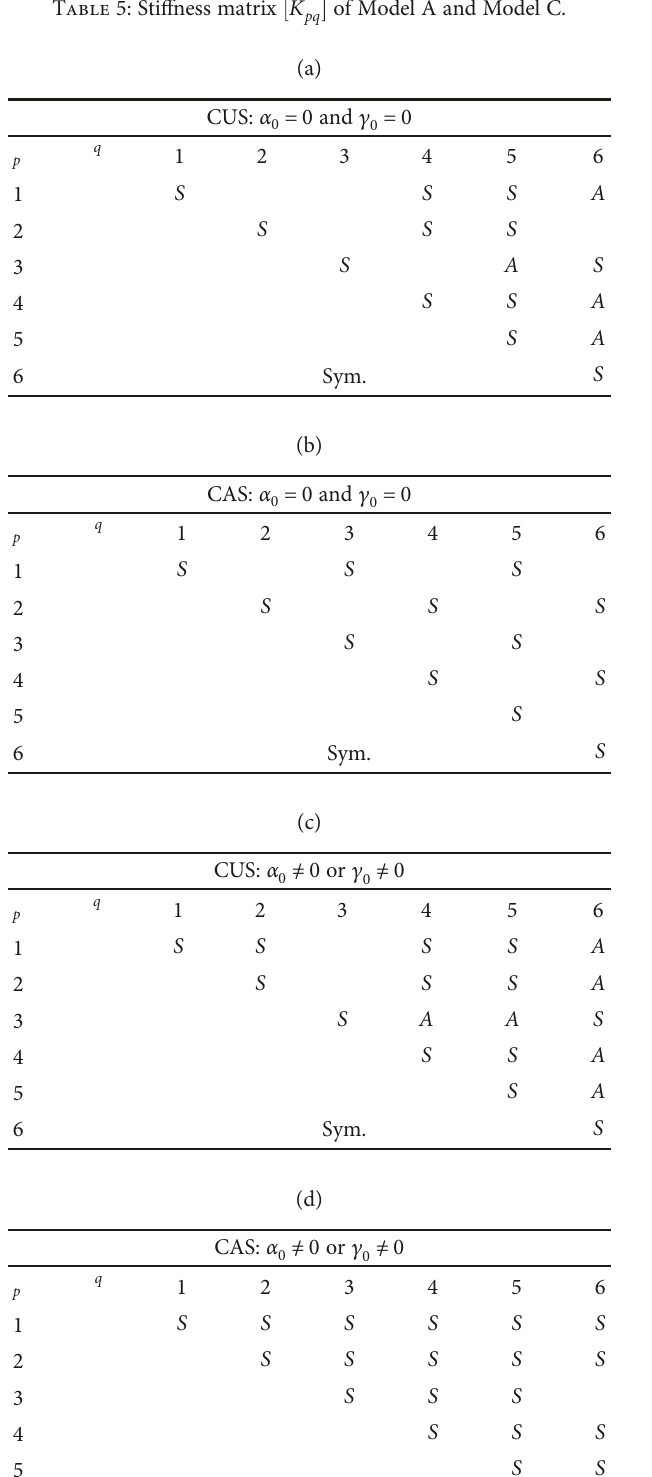
Table 5: Sti ff ness matrix K